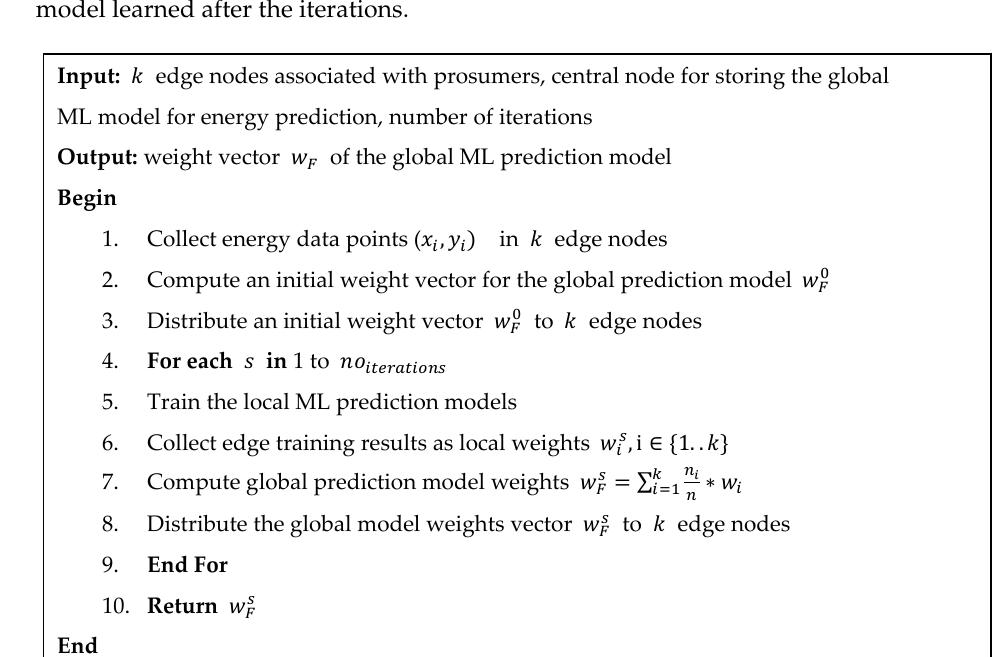
Figure 4. Blockchain-based distributed FL for prosumers energy prediction.